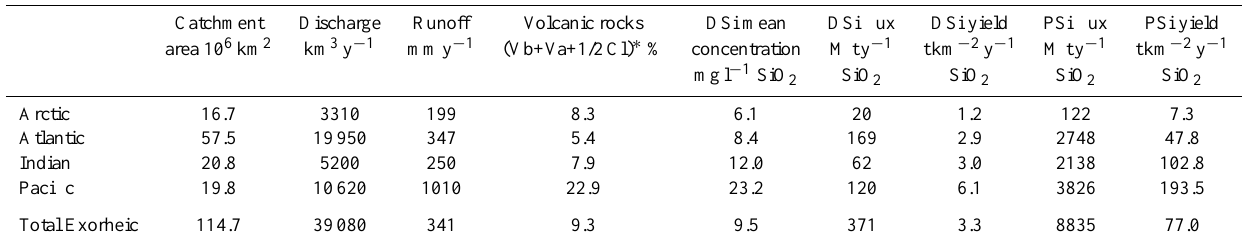
Table 2. Average dissolved and particulate silica fluxes, concentrations (runoff weighted averages) and yields (area weighted averages) from catchments to coastal zones related to ocean basins. Catchment surface area, discharge and runoff are given as well as % of volcanic rocks from D¨urr et al.